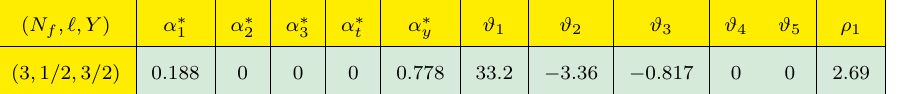
ratio for the model that 1